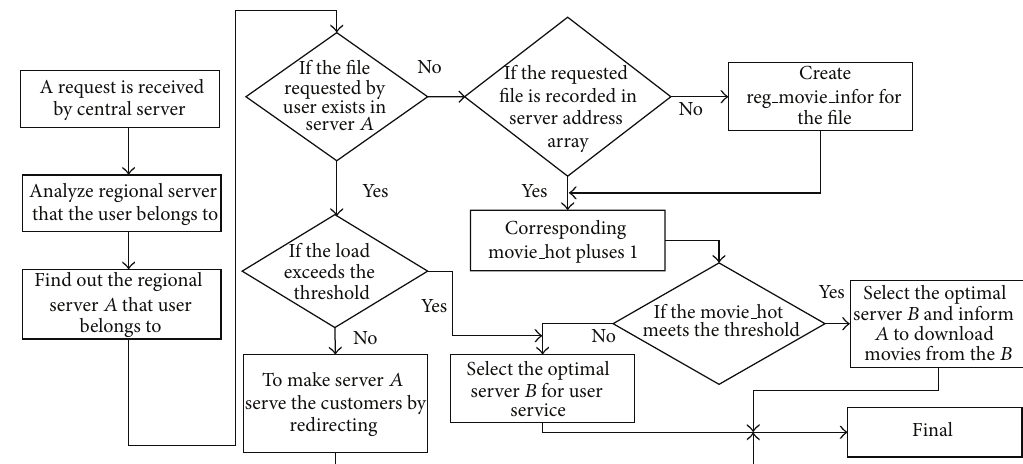
Figure 5: Schedule process of